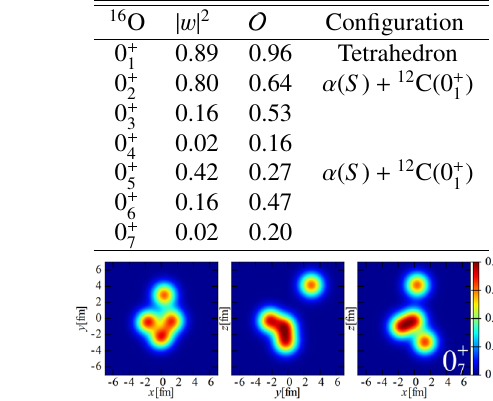
Figure 1. Energy spectra of 16 O(0 + ) states measured from the 4 α threshold of the eTHSR [2] and REM.